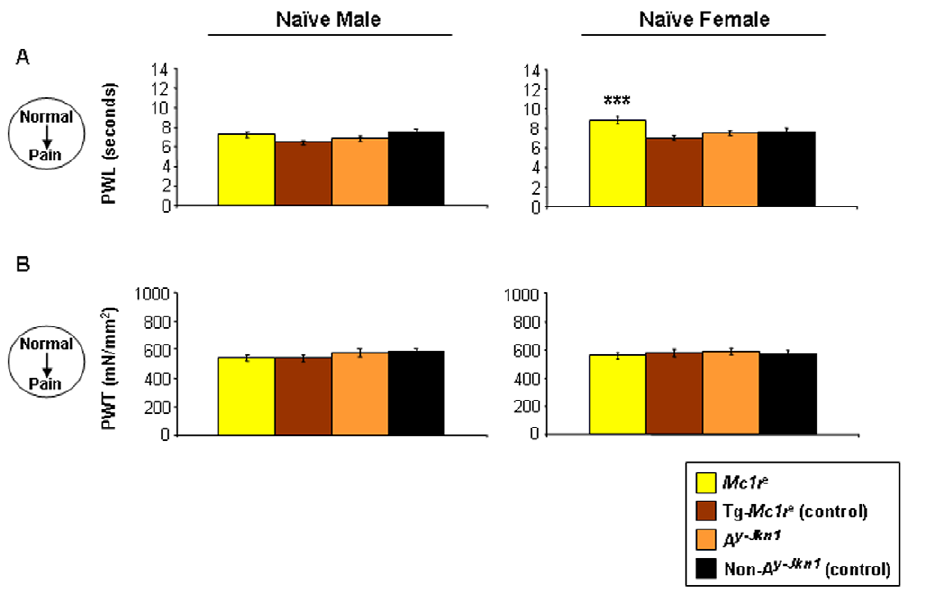
Figure 1. Behavioural responses to acute mechanical or noxious thermal stimuli in naı¨ve animals. Adult male and female Mc1r e and their littermate controls Tg- Mc1r e , or A y-Jkn1 and their littermate control non- A y-Jkn1 mice were assessed for responses to acute noxious thermal or non- noxious mechanical stimuli. The paw withdrawal latency (PWL; n=8–11 per genotype) [ A ], paw withdrawal threshold (PWT; n=8–11 per genotype) [ B ] as measures of thermal hyperalgesia and mechanical allodynia respectively of both hind-paws (right and left hind-paw responses combined) in naı¨ve animals are shown as mean responses 6 SEM. Significant differences between Mc1r e and A y-Jkn1 and their respective controls were only seen in female Mc1r e mice in [ A ] paw withdrawal latency (***P , 0.01).